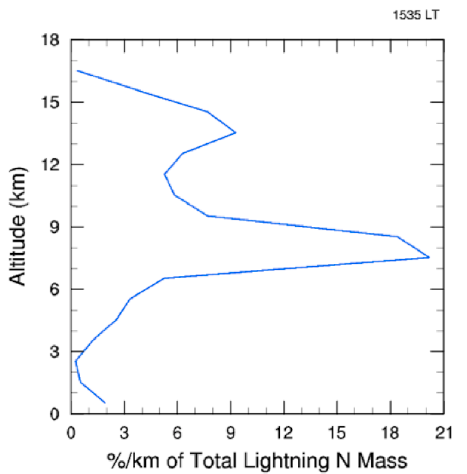
Fig. 19. Vertical cross sections of O 3 mixing ratios, oriented 130 ◦ from north through the storm core, for simulations (a) without and (b) with lightning NO production. The cross sections occur dur- ing a peak in average NO x production within the layers centered at 12.0km and 12.7km. The thin black line indicates the 0.01gkg − 1 total condensate